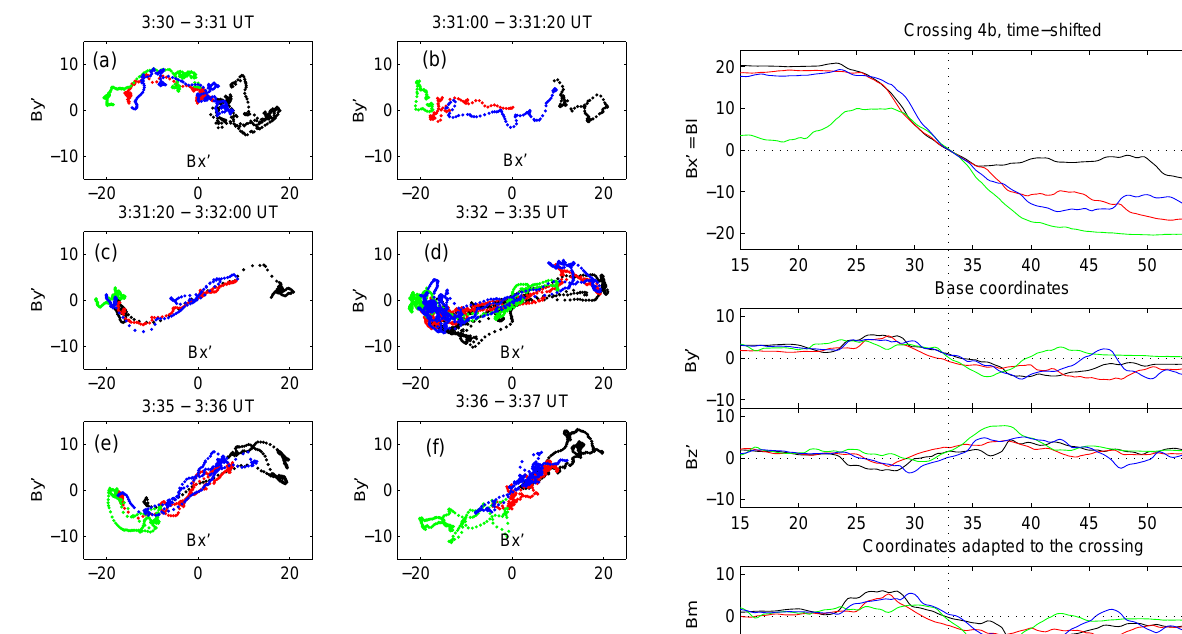
Fig. 6. B y 0 versus B x 0 in six consecutive time intervals during the reconnection event, illustrating the Hall effect. The colours refer to different spacecraft: data from Cluster 1 is in black, C2 in red, C3 in green and C4 in blue. Table 2. The normal vector and the normal velocity of the cur- rent sheet in three pairs of crossings, marked in Fig. 3. The nor- mal vector components are given in GSM ( [ x,y,z ] ) and rotated ( [ x 0 ,y 0 ,z 0 ] ) coordinates. The results have been obtained by timing analysis.